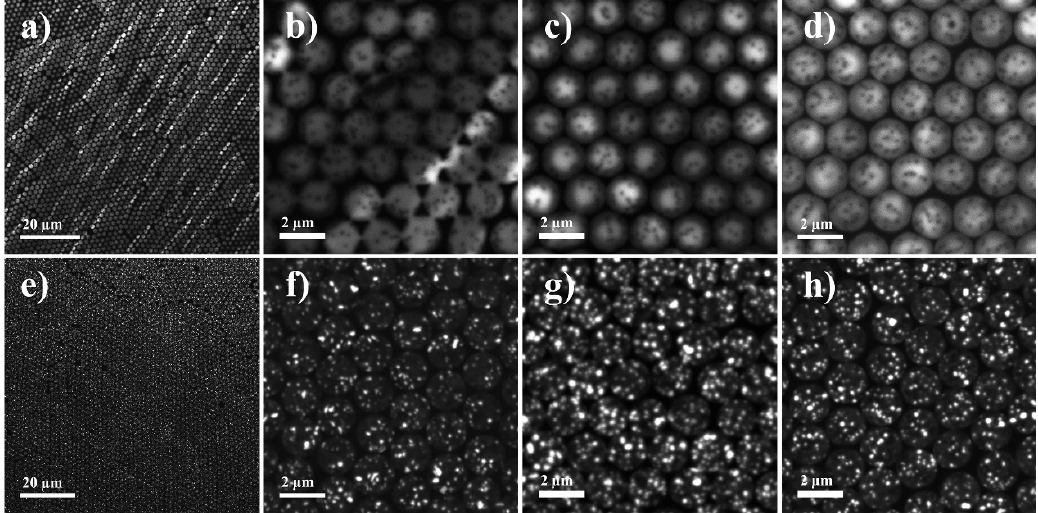
Figure 6. Low magnification ( a ) and high magnification panchromatic cathodoluminescence (CL) mapping of as-fabricated ( b ), KOH treated ( c ) and thermally treated ( d ) III-polar nanopillar MQWs. CL mapping of N-polar nanopillar MQWs are illustrated in ( e – h ),